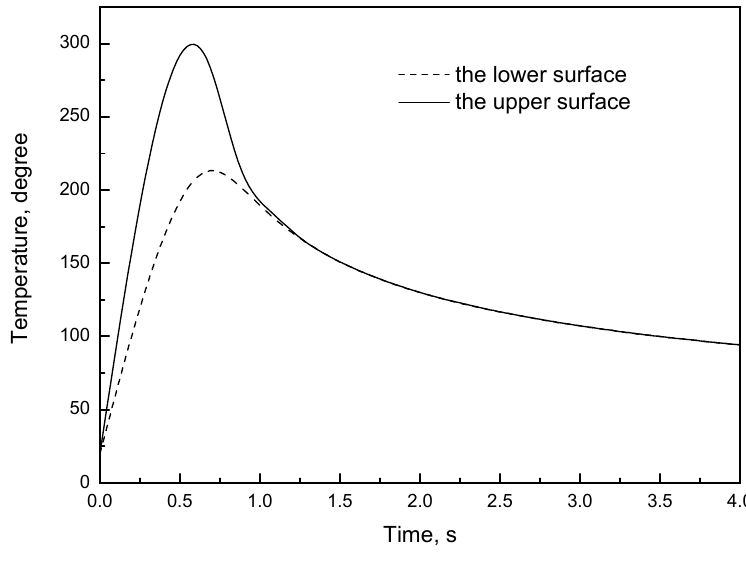
Figure 3. Temperature of the upper and lower surface along with